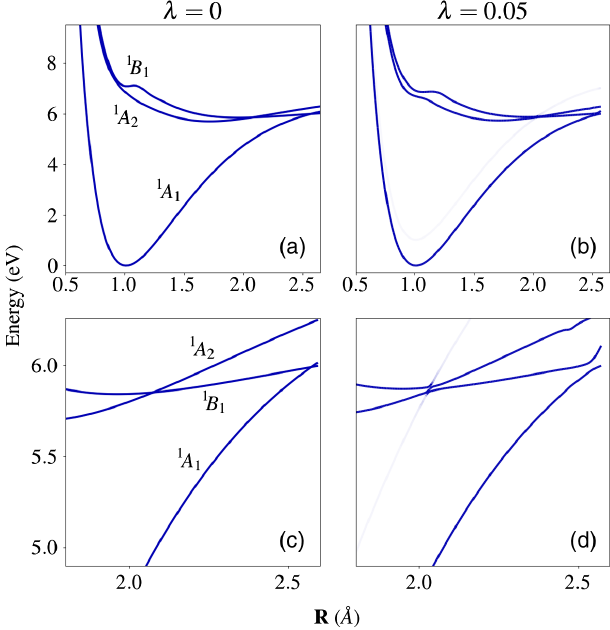
FIG. 6. QED-CCSD-1 excited-state charge displacement analy- sis of PNA with and without an optical cavity ( λ ¼ 0 . 05 and ω res 4 . 84 eV). The charge displacement functions with the cav ¼ cavity for lower (LP, blue) and upper (UP, red) polaritons are shown in panels (a) – (d). In green, we show the function for the charge transfer state without the cavity. The dashed black line represents the sum of the curves for LP and UP.